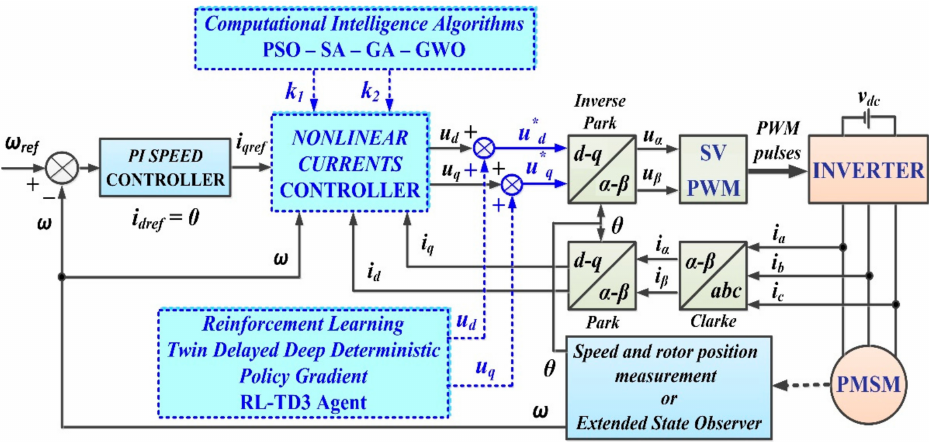
Figure 5. The proposed PMSM–CS–CI control block diagram based on a nonlinear-type